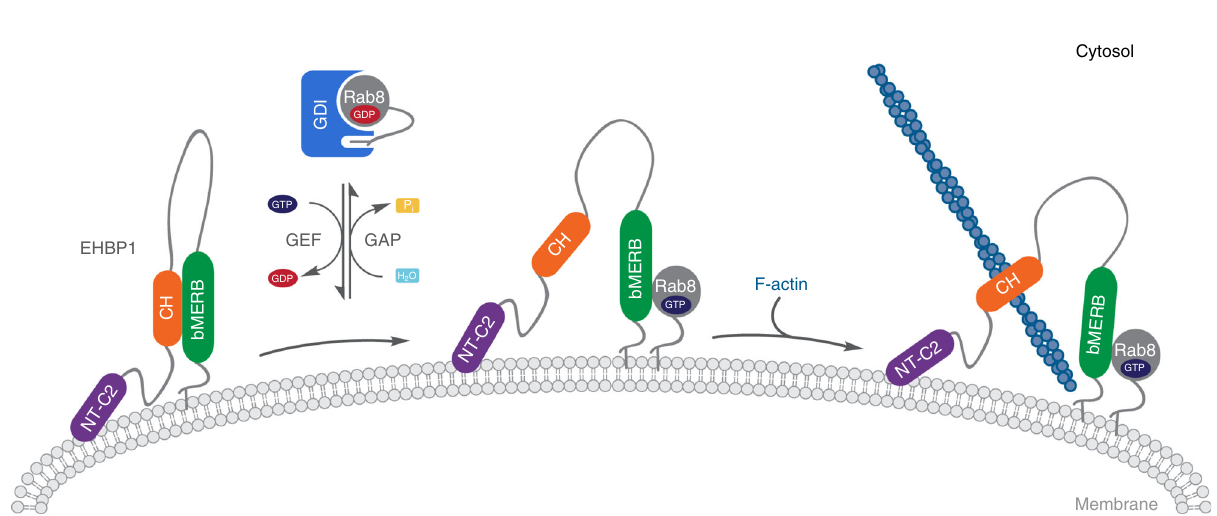
Fig. 8 Mechanistic model of the EHBP1 activation by Rab8 family members. In the absence of active Rab8, EHBP1 exists in a closed conformation in which the CH domain interacts with its bMERB domain. Rab8 is recruited to the membrane by its GEF molecule (e.g., Rabin 8 or GRAB) and the resulting active GTP bound Rab8 interacts with the EHBP1 bMERB domain; this interaction makes the CH domain available for F-actin